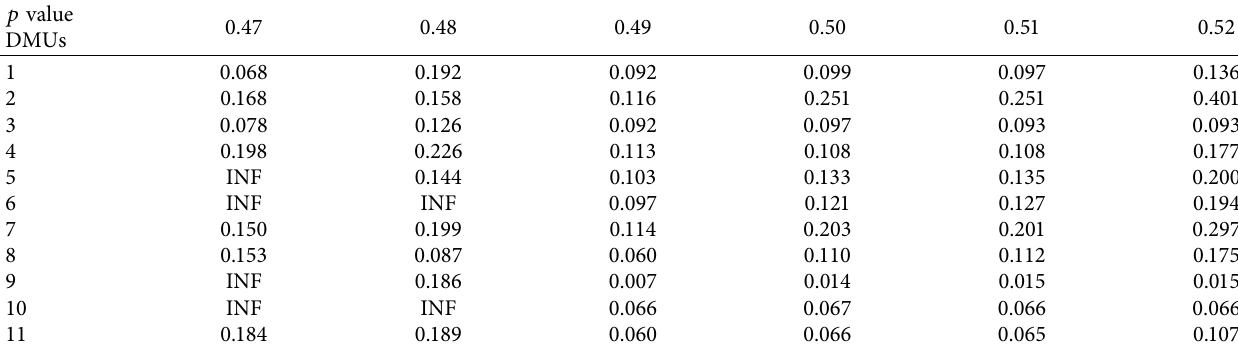
Table 9: The sum of the efficiency scores of models (12) and (13).